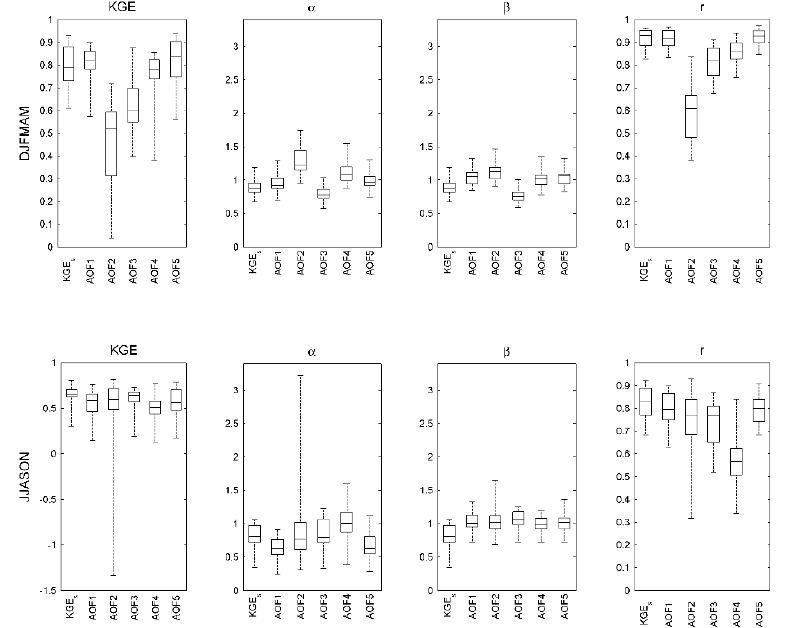
Figure A1. Hydrologic annual performance over the validation period for the Du Loup catchment (see Figure 6 for further description).